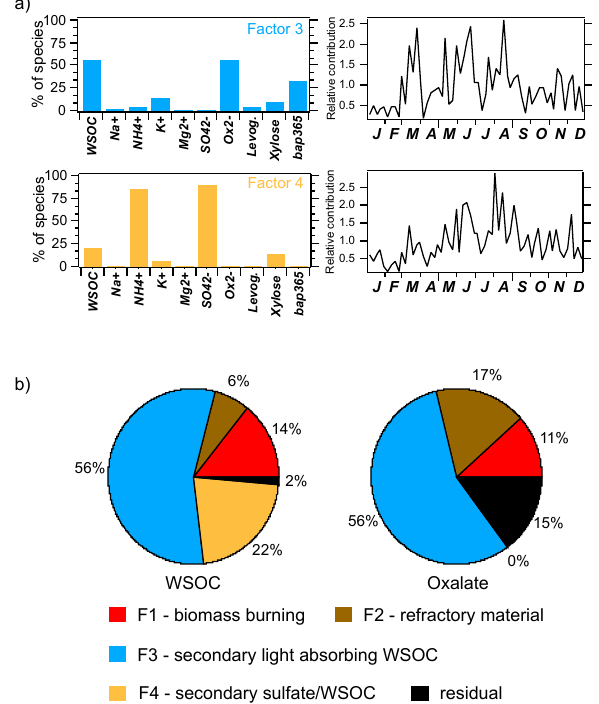
Fig. 10. Results from PMF analysis detailed by Zhang et al. (2010) showing: (a) composition profiles and relative contributions of fac- tors 3 and 4 throughout the year of 2007, and (b) average loading of WSOC and oxalate amongst the four PMF